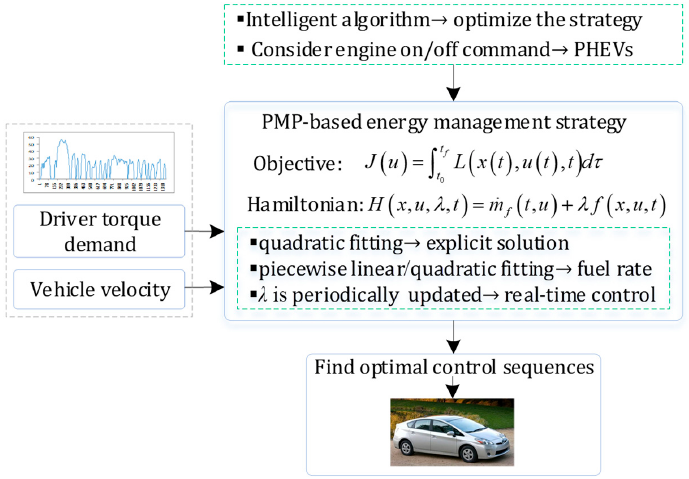
Figure 6. Depiction of the main research areas of the PMP-based strategy.